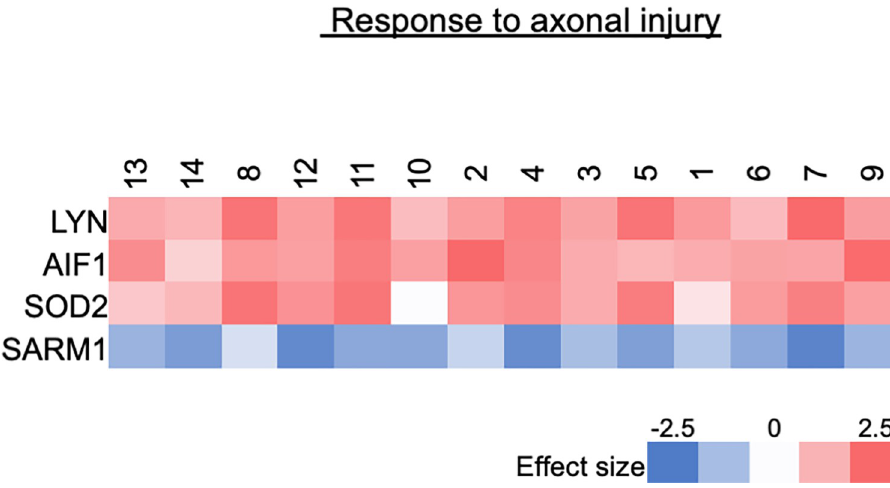
Fig 9. Axonal response after injury Graph of mass spectrometry analysis of all the protein products that were significantly upregulated or downregulated from the GO pathway, “Response to Axonal Injury” (q-value � 0.05 and Z � |2| (log2), range -2.5 to